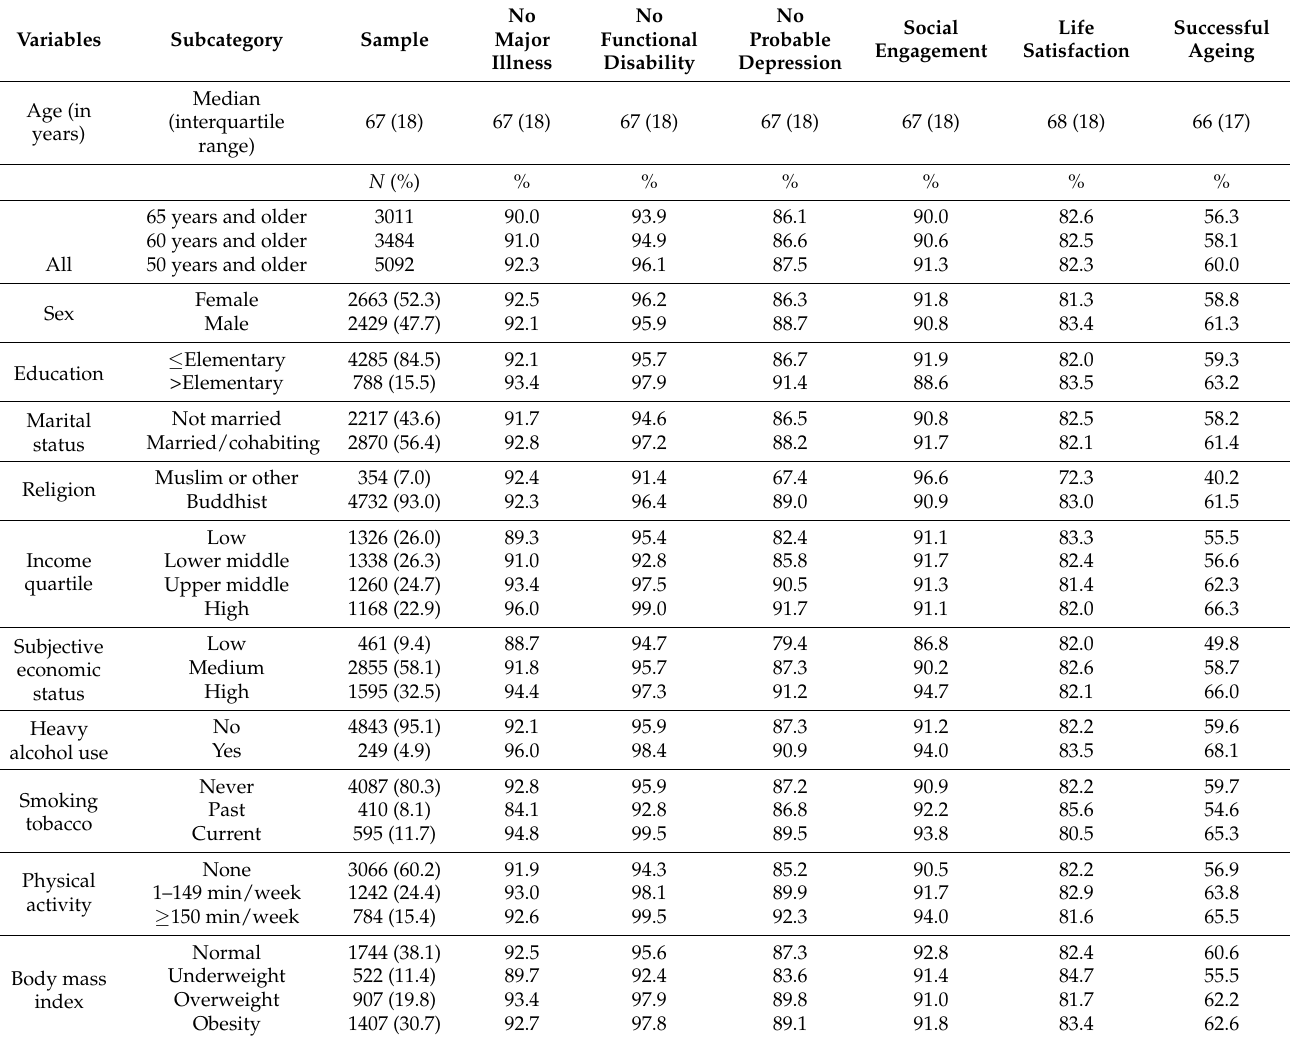
Table 1. Sample and successful ageing characteristics in older adults ( ≥ 50 years) in Thailand,